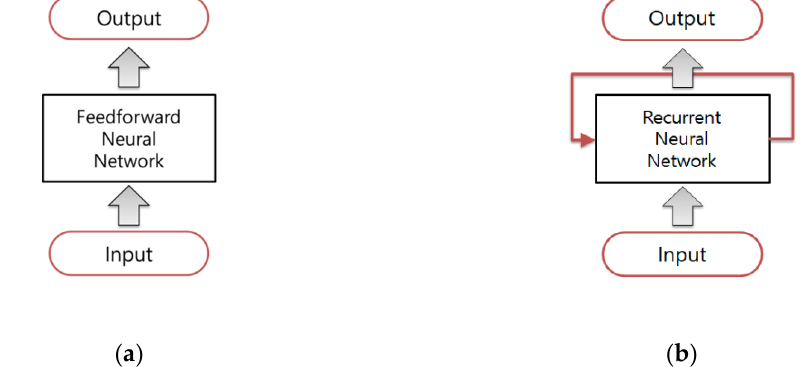
Figure 1. Difference between feedforward and recurrent neural networks: ( a ) Feedforward neural network; ( b ) Recurrent neural network.